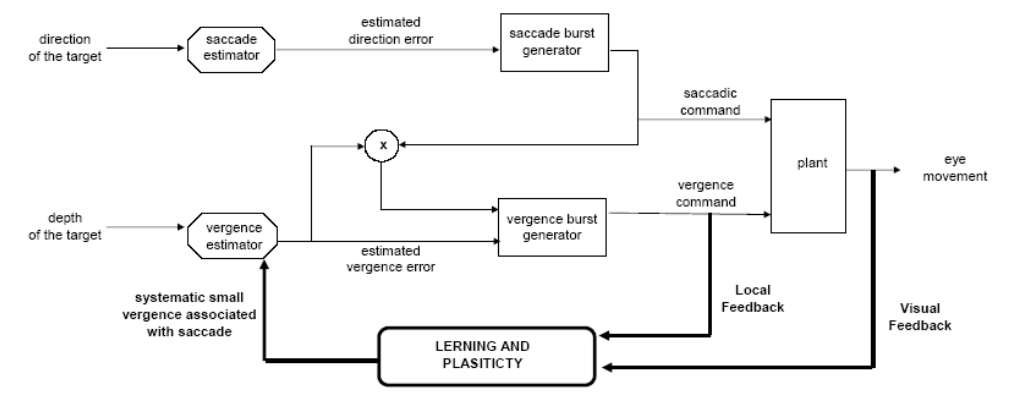
Figure 12. Conceptual model of binocular coordination of saccades using the saccade vergence interaction, inspired by models of Zee et al. (1992) and Busettini and Mays (2005). Target position is coded as direction and vergence errors (i.e. direction and vergence differences between desired position and current position). Saccade and vergence commands (pulse-slide-step, not shown) are elaborated at the brainstem (burst neurons); these commands are sent to the ocular motoneurons and orbital plant. Local feed- back loops and visual feedback loops (not shown for saccade command), involving brainstem, cerebellum, and cortical areas such as PPC, allow online control of movement execution and long term calibration of the systems. Together with every saccade, a small vergence command is elaborated; the size of the vergence command is the result of prior learning and visual experience.